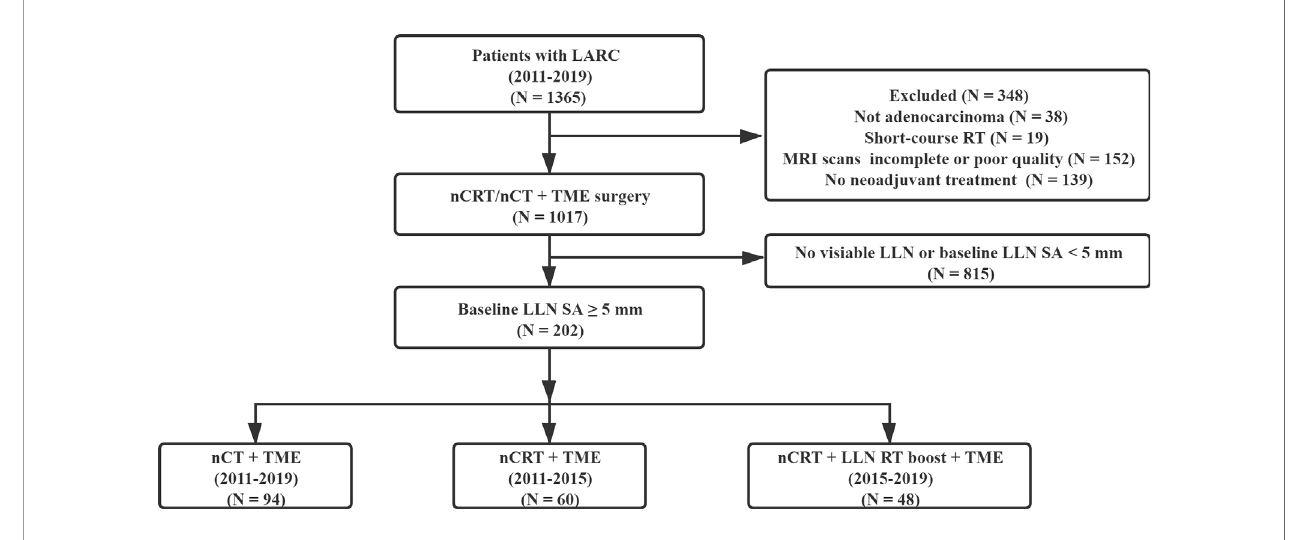
FIGURE 1 | Patient fl owchart.